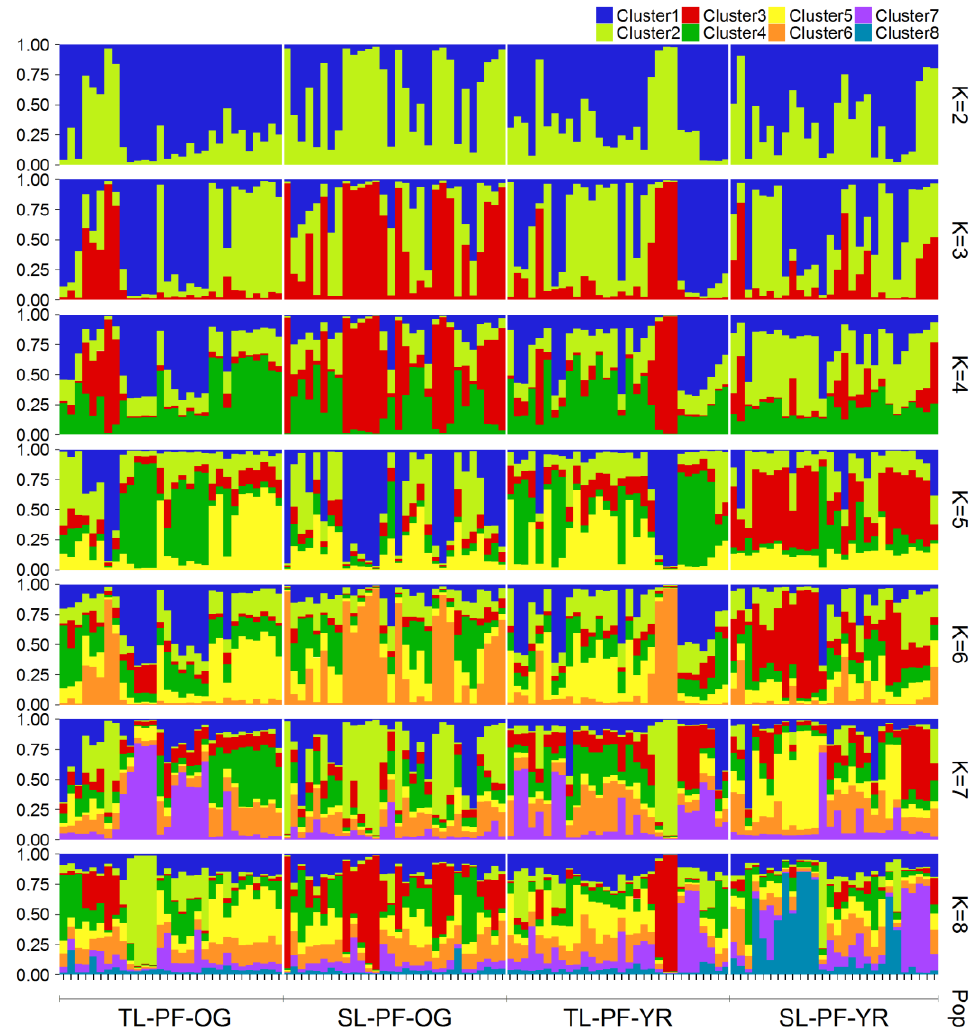
Figure 4. The summary bar plot of the estimated membership coefficient (Q) of the studied white spruce individuals from four populations from the STRUCTURE analysis for K = 2–8. Each indi- vidual is represented by a single vertical line while each color represents one cluster/genetic